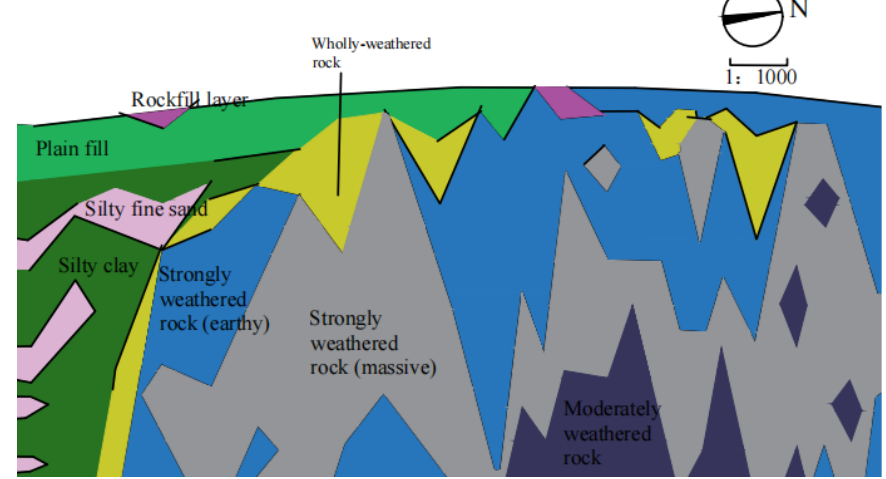
Figure 4. Geological profile.